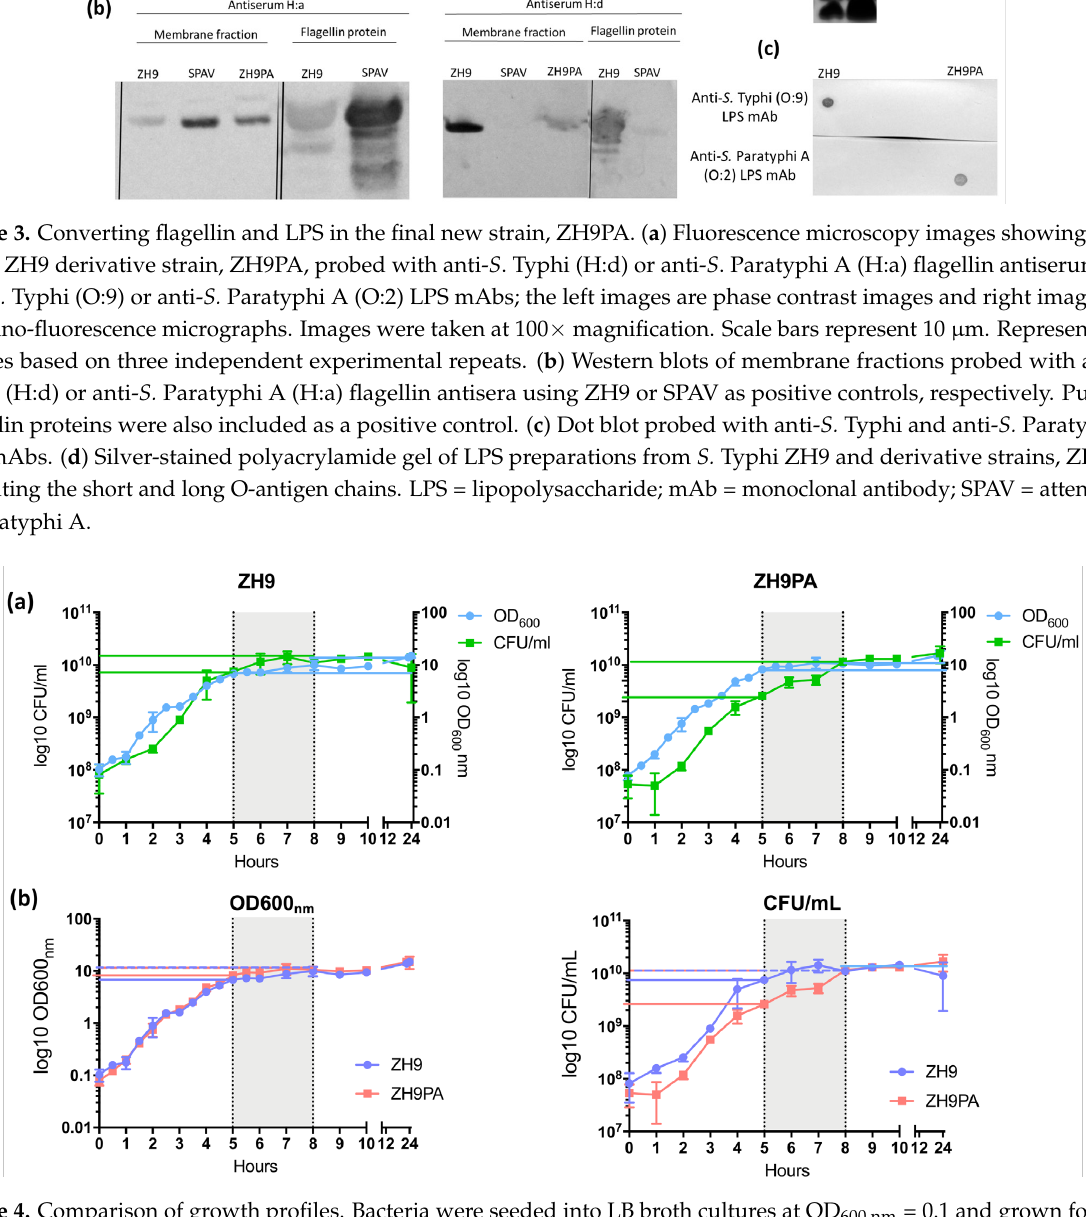
Figure 4. Comparison of growth profiles. Bacteria were seeded into LB broth cultures at OD 600nm = 0.1 and grown for 24 h. At regular intervals, samples were taken and analysed by spectrophotometry or by titration on agar plates. Optical density (a measure of growth density) and bacterial titre were plotted for ZH9 (the parental strain) and ZH9PA (the modified strain). The late exponential growth phase (5 to 8 h) is shown in grey. ( a ) OD 600nm and CFU/mL measurements compared within each individual strain. ( b ) OD 600nm or CFU/mL measurements compared between both strains. Statistical comparisons were made using a two-way ANOVA, based on triplicate cultures in a single experiment. CFU = colony-forming units; ml = millilitres; nm = nanometres.